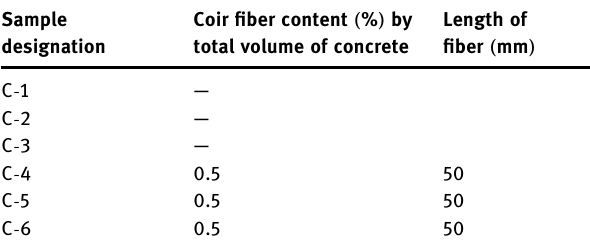
Table 3: Cylindrical specimen details for each day of compression